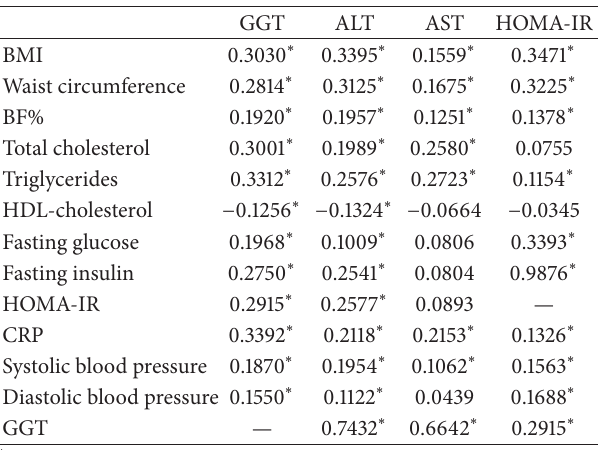
Table 3: Partial correlation of serum GGT, ALT, and AST with other variables and anthropometric variables in